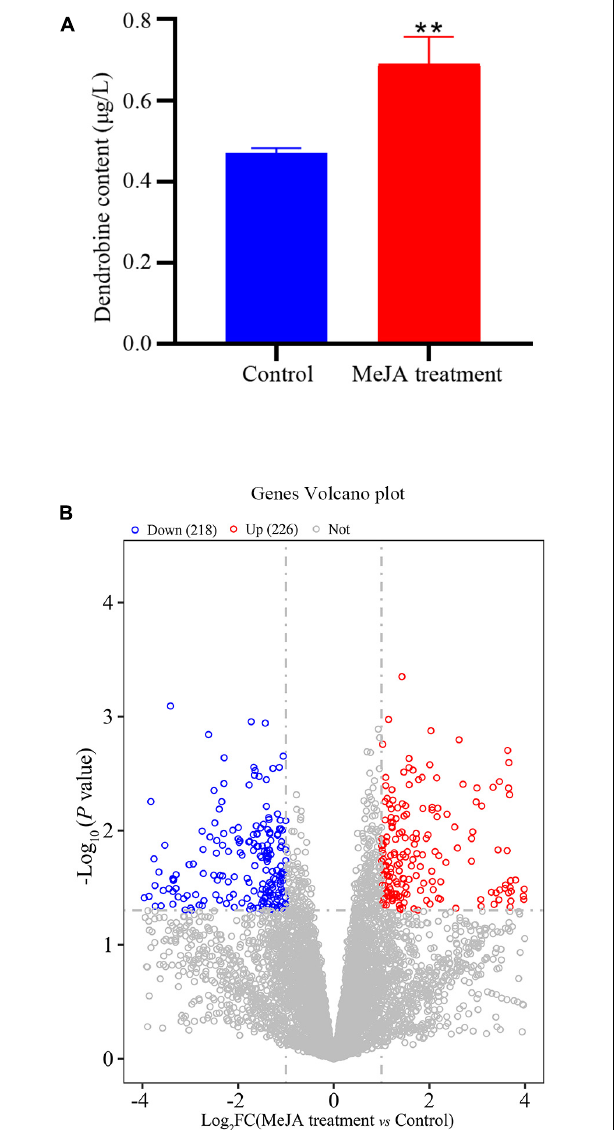
FIGURE 3 | Transcriptional variation between Control and MeJA treatment groups. (A) In the MeJA treatment group dendrobine content increased 44.6%, (B) significance analysis of all DEGs between the strain MeJA treatment MD33 and Control by a volcano plot. ** p <